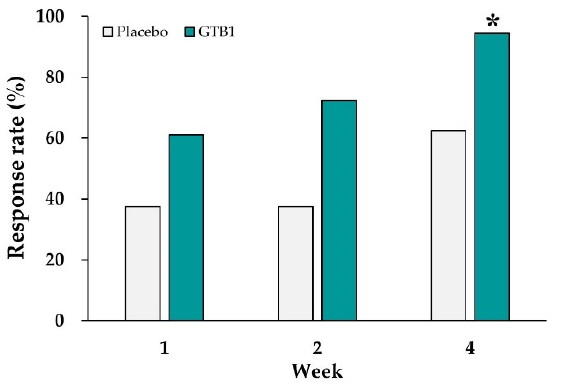
Figure 2. Response rates (%) for global relief of irritable bowel syndrome (IBS) symptoms after GTB1 and placebo ingestion. Data are presented as responder rates (%). * p < 0.05 as determined by Chi-square test. Table 2. Comparison of intestinal discomfort symptoms during study periods. Abdominal Pain Abdominal